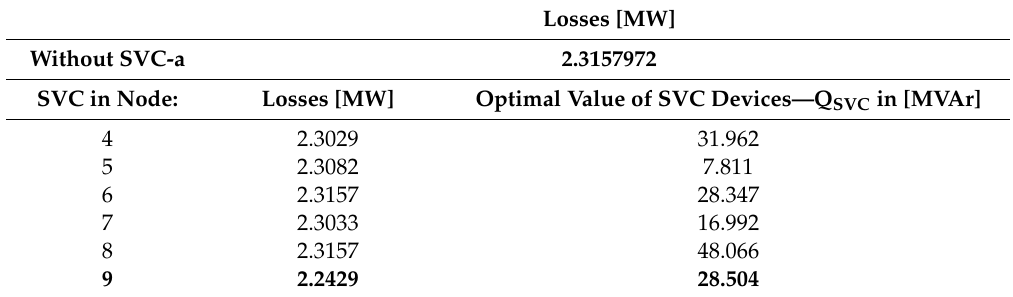
Table 2. Power losses (MW) without and with SVC in the IEEE 9 test bus system—CASE 1.